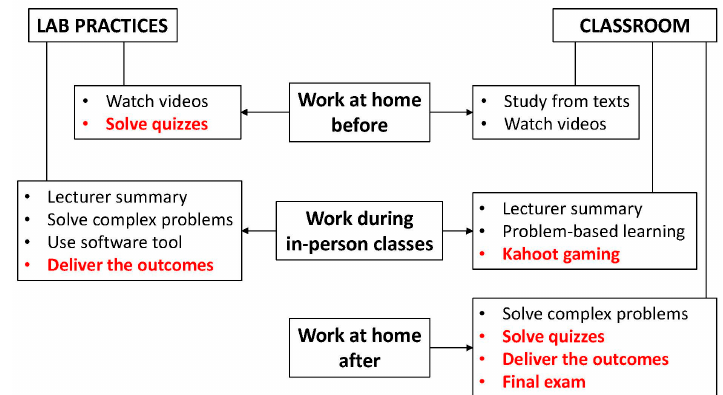
Figure 1. Summary of student’s activities.